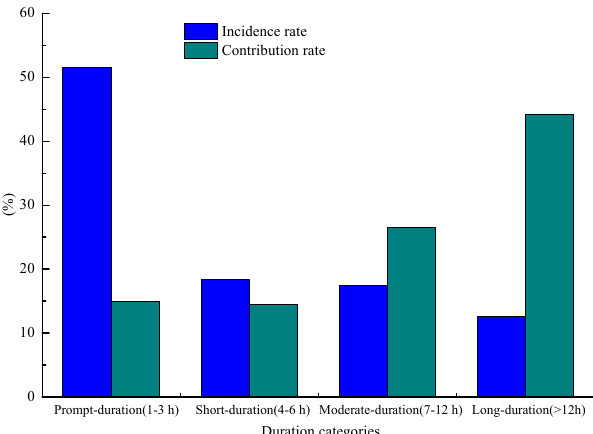
Figure 4. Distribution of the incidence and contribution rates of different rainfall durations during the RS in the LP. Water 2020 , 12 , x FOR PEER REVIEW